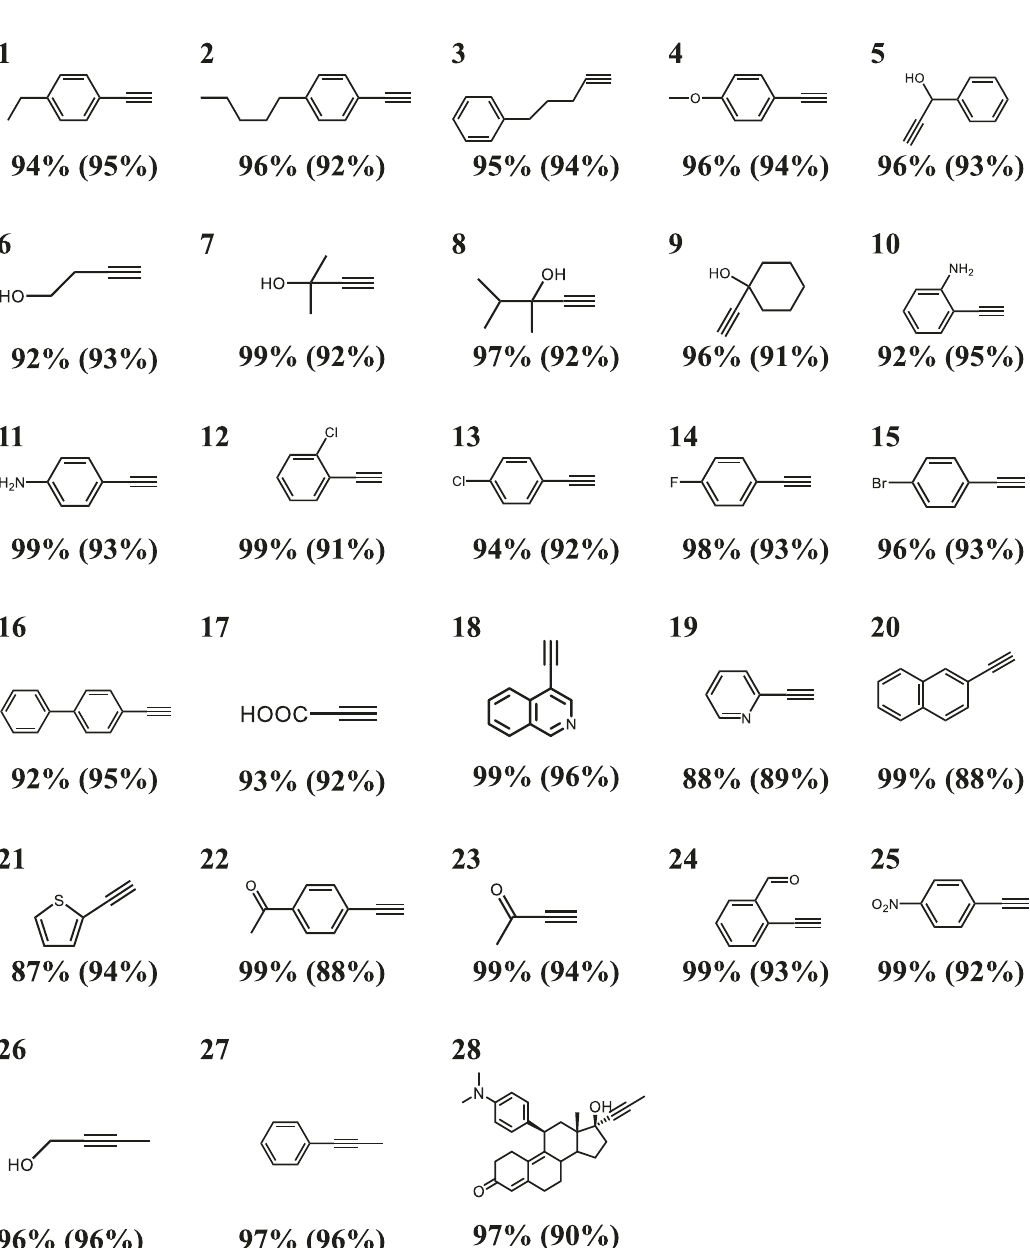
Table 1 | The performance of Pd/Nb 2 C catalyst toward different